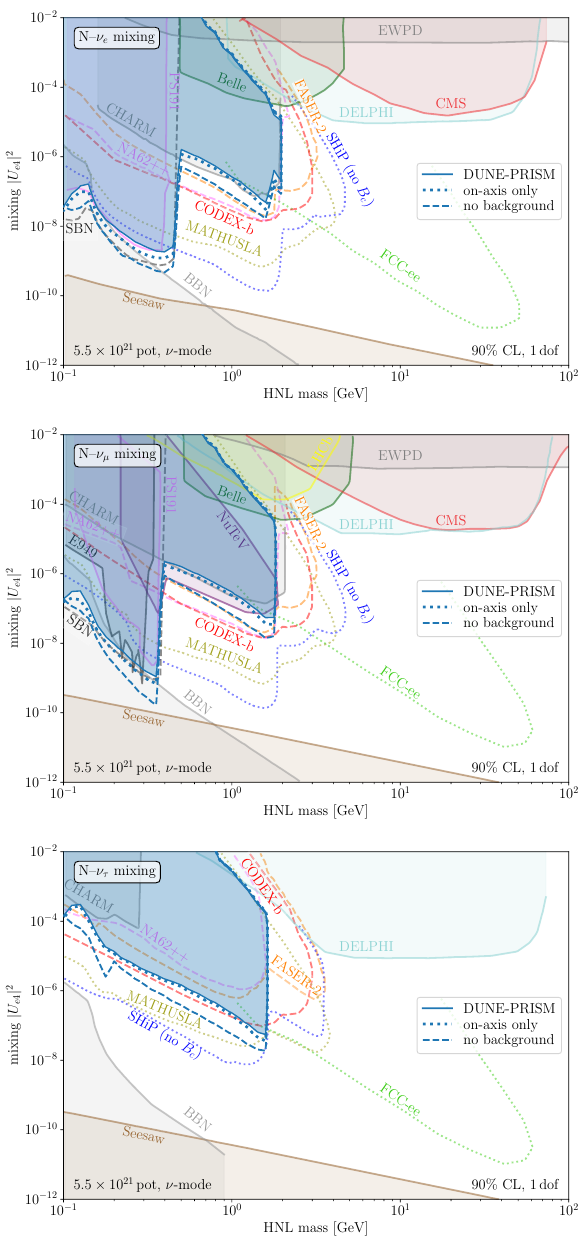
Figure 11 . The DUNE near detectors compared to other experiments sensitive to HNLs. The top, middle, and bottom panels show the sensitivity to the squared mixing matrix elements | U | U µ 4 | 2 , and | U τ 4 | 2 , respectively, assuming that only one of them is non-zero at a time. In this plot, the decay channels νe + e − , νµ + µ − , νe ± µ ∓ , νπ 0 , π ± e ∓ , π ± µ ∓ are combined. As in figure 10, solid blue curves show the sensitivity of DUNE-PRISM ( 5 . 5 × 10 21 pot in neutrino mode, equally split between the on-axis position and six different off-axis locations). Dotted blue contours show results for on-axis running only, and thin dashed blue curves represent a hypothetical background- free analysis. The contours shown in the background correspond to existing limits (filled) and sensitivities of planned experiments (unfilled dashed and dotted). These limits are taken from the compilation in ref. [54] and from ref.